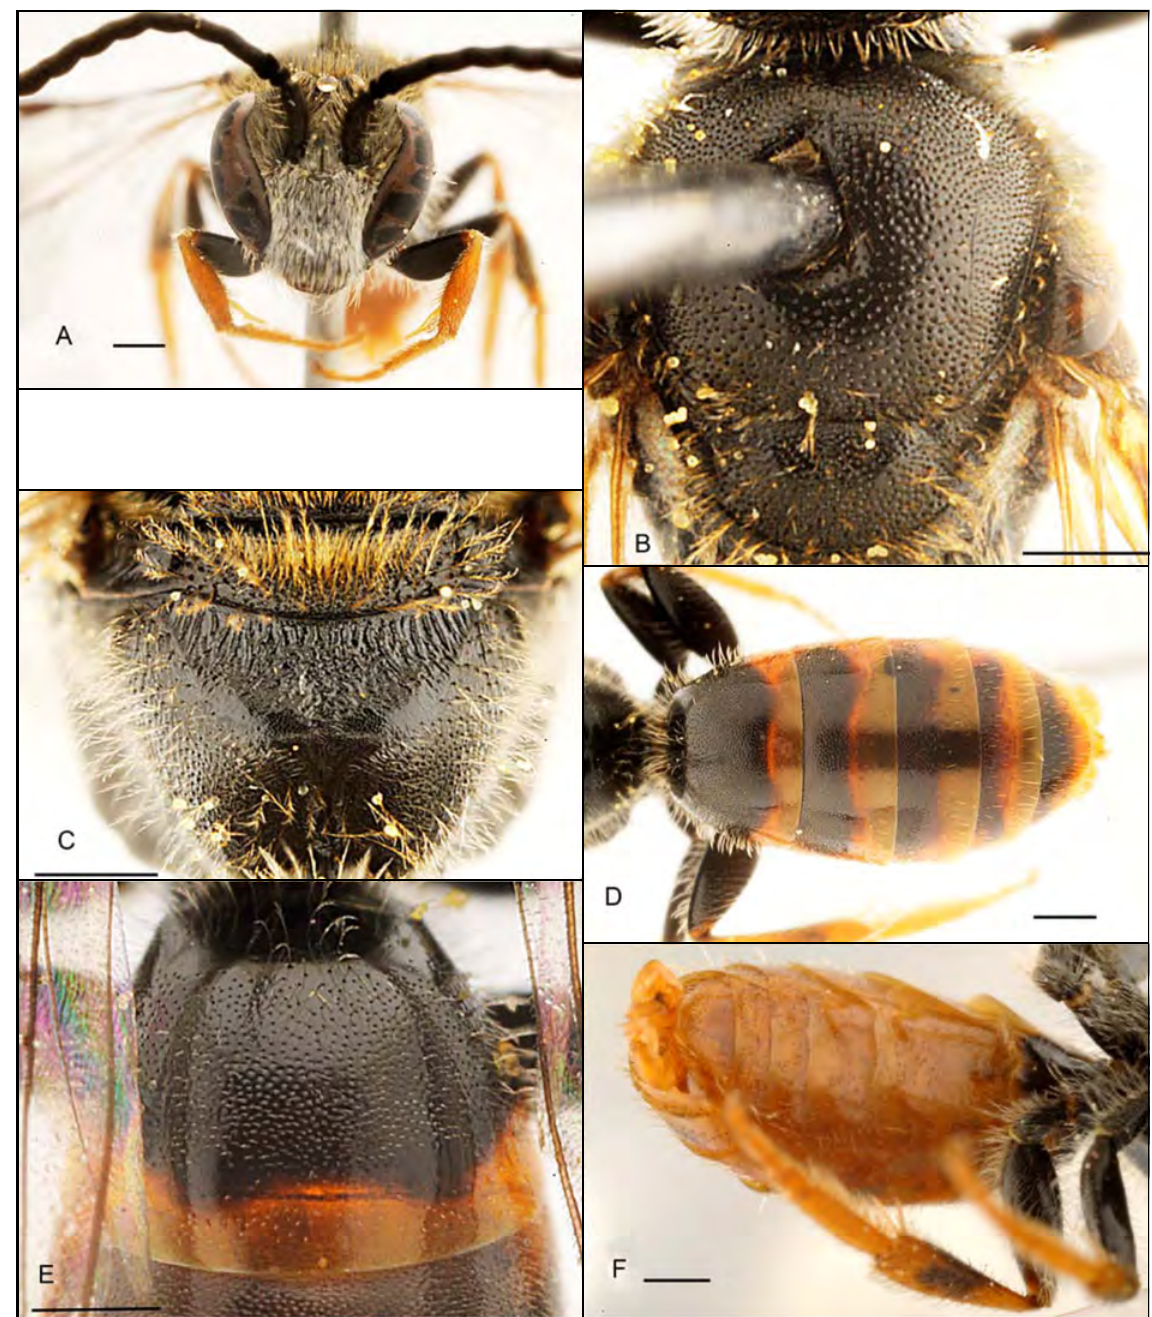
Fig. 6. Lasioglossum ( Capalictus ) tigrinum sp. nov., ♂. A . Head and forelegs. B . Mesoscutum and scutellum. C . Propodeum and metanotum. D . Metasoma, dorsal view. E . First tergum. F . Metasoma ventral view. Scale line = 0,5